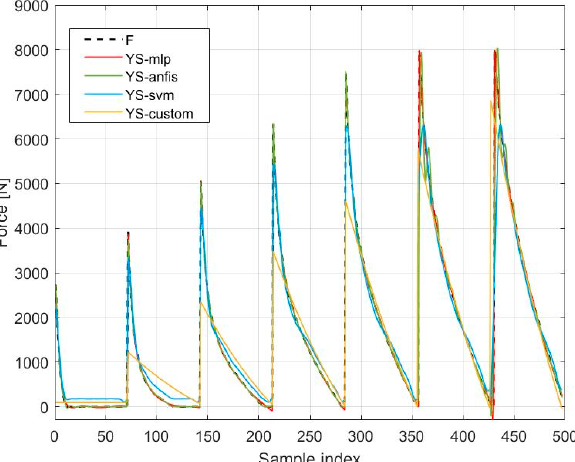
24 of 34 dashed line labeled F. The outputs of the individual models are shown by solid colored lines: